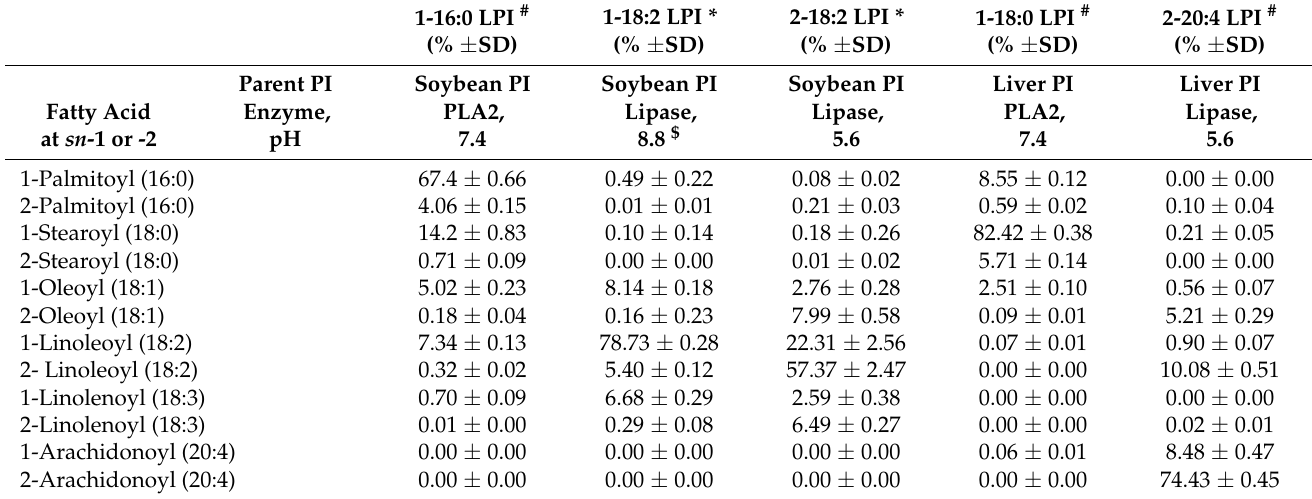
Table 1. The purity and the concomitants of soybean- and liver-derived LPIs. These LPIs were prepared by treating soybean or bovine liver PI with Naja atra PLA2 or Rhizopus delemar lipase under the indicated pH conditions. Values represent the means ± SDs from three independent